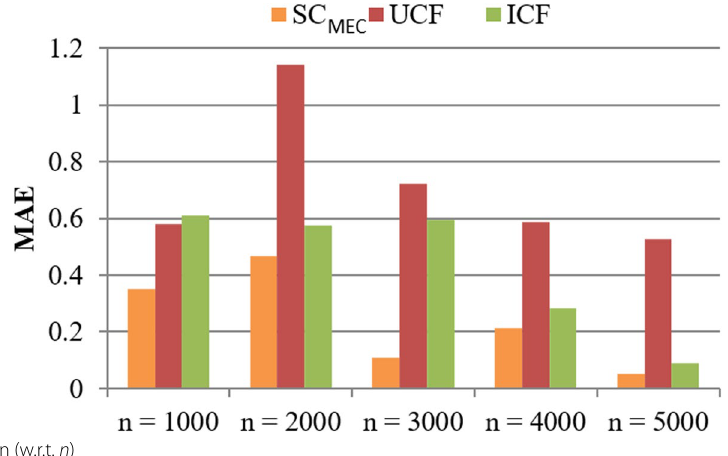
Fig. 5 Accuracy comparison (w.r.t. n )